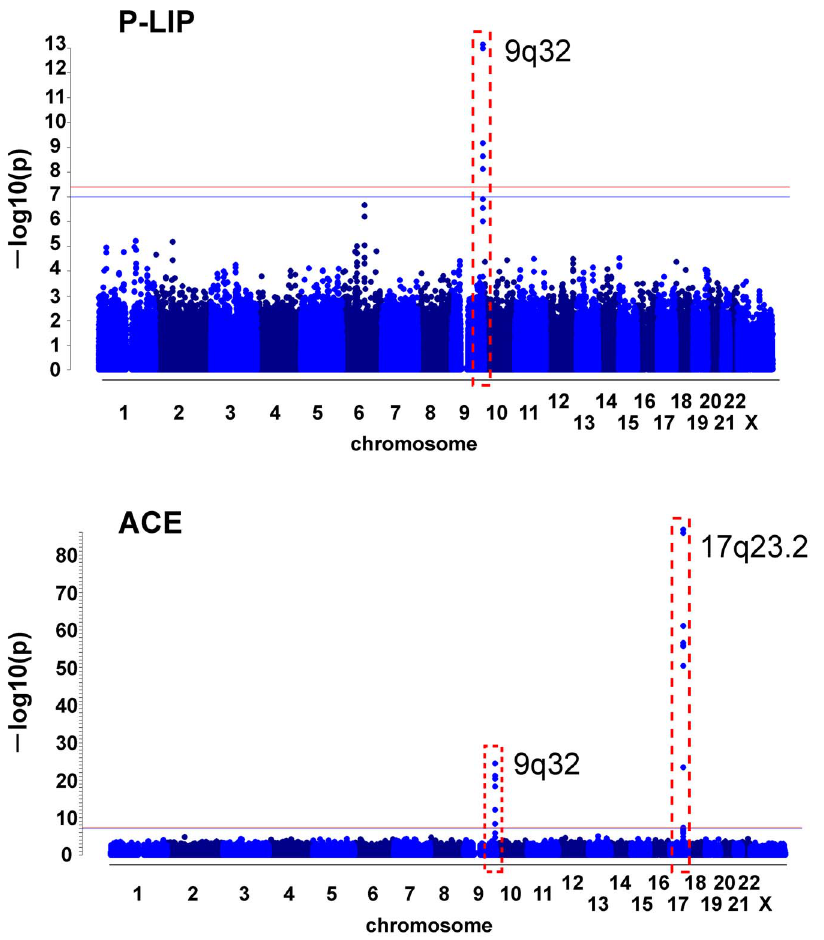
Figure 1. Manhattan plot for genome-wide association signals with the P-LIP (upper panel) and ACE (lower) levels in the Takahata population by linear regression with adjustment for age and gender as covariates. The red line represents a genome-wide significance level (5 6 10 2 8 ), whereas the blue line represents a genome-wide suggestive level (1 6 10 2 7 ). The red broken boxes indicate loci having the SNPs that attained a genome-wide significance level or the Bonferroni’s corrected level by the number of